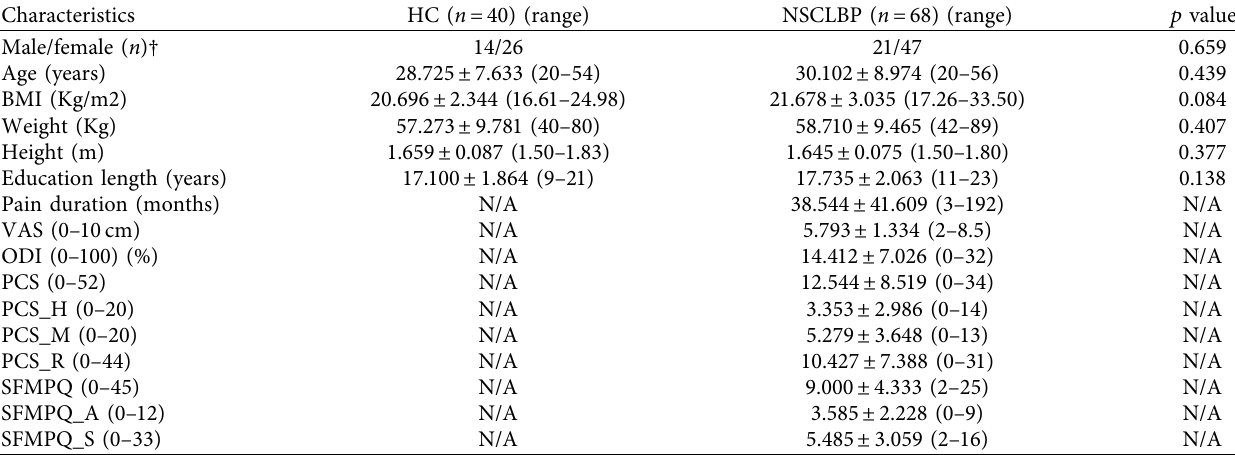
Table 1: Temperature and wildlife count in the three areas covered by the study.